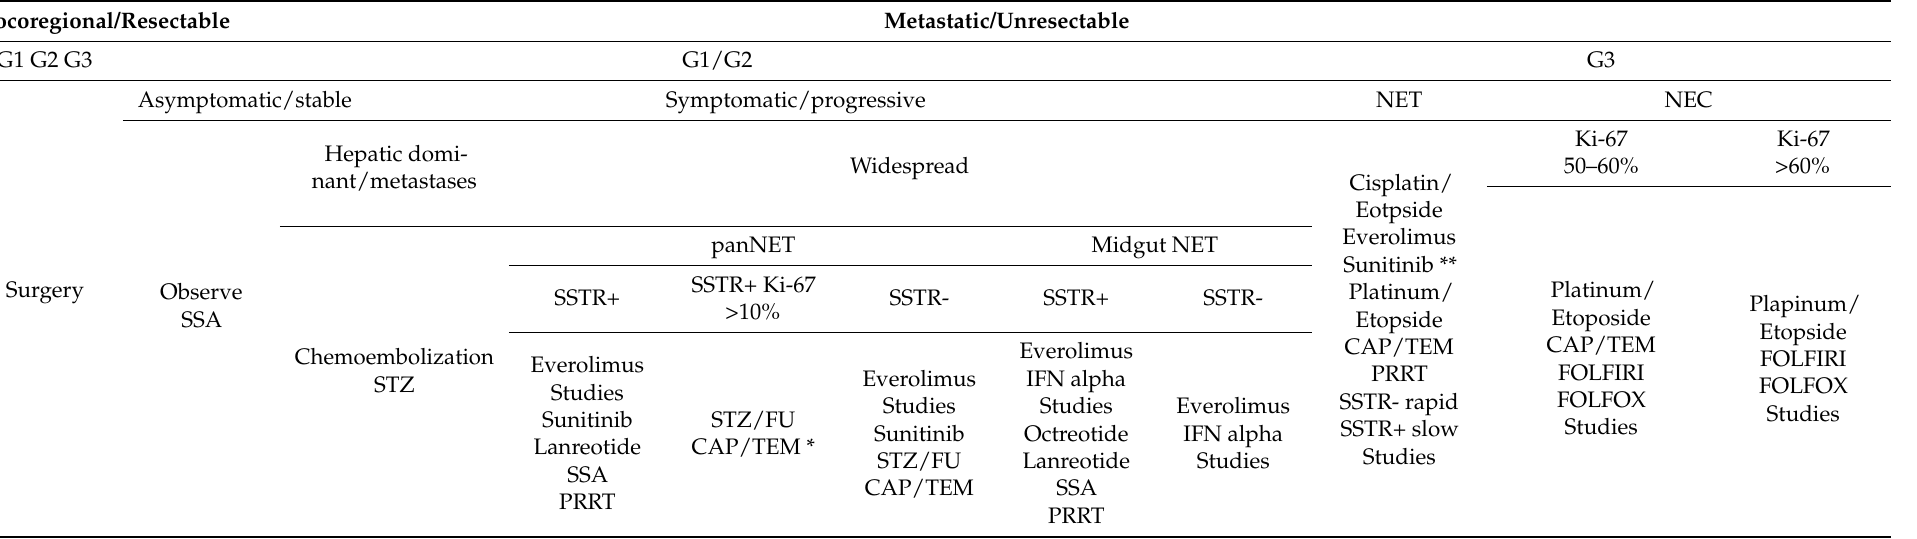
Table 4. Treatment regimen for GEP NETs and GEP